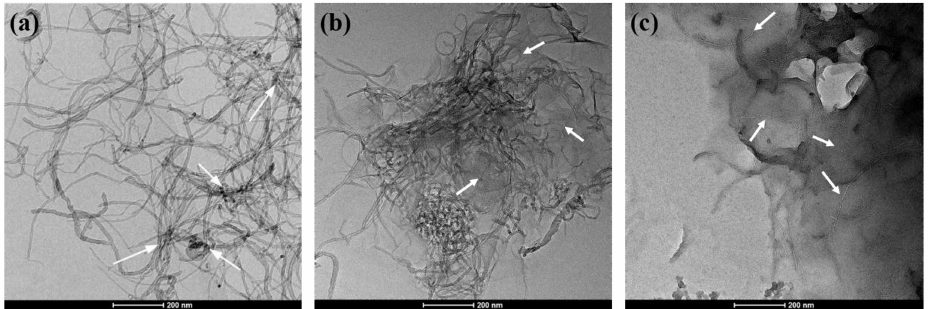
Figure 3. TEM micromorphology of ( a ) CNTs, ( b ) GO-CNTs, and ( c ) M-GO-CNTs.